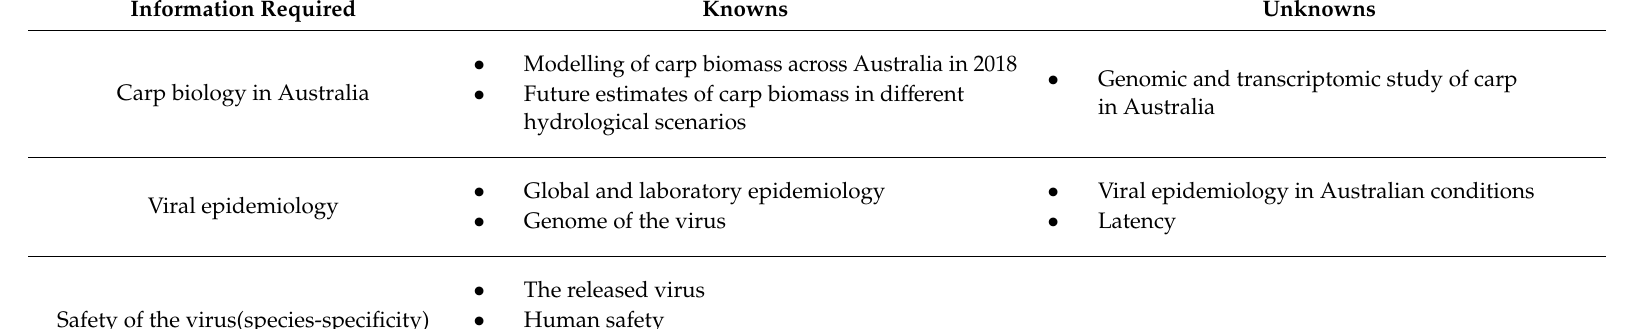
Table 1. The essential information required for potential viral biocontrol of